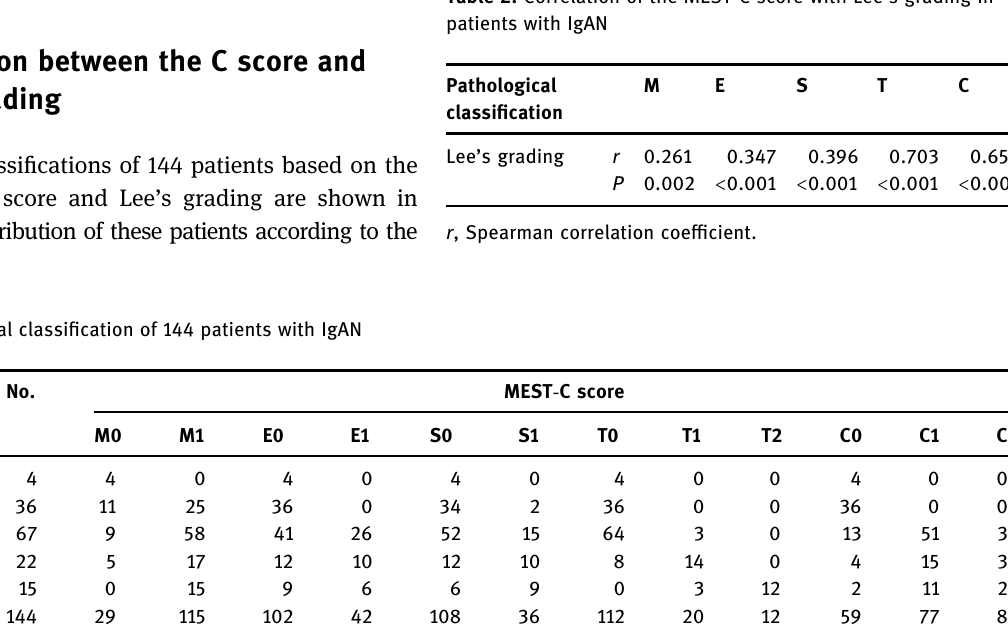
Table 2: Correlation of the MEST - C score with Lee ’ s grading